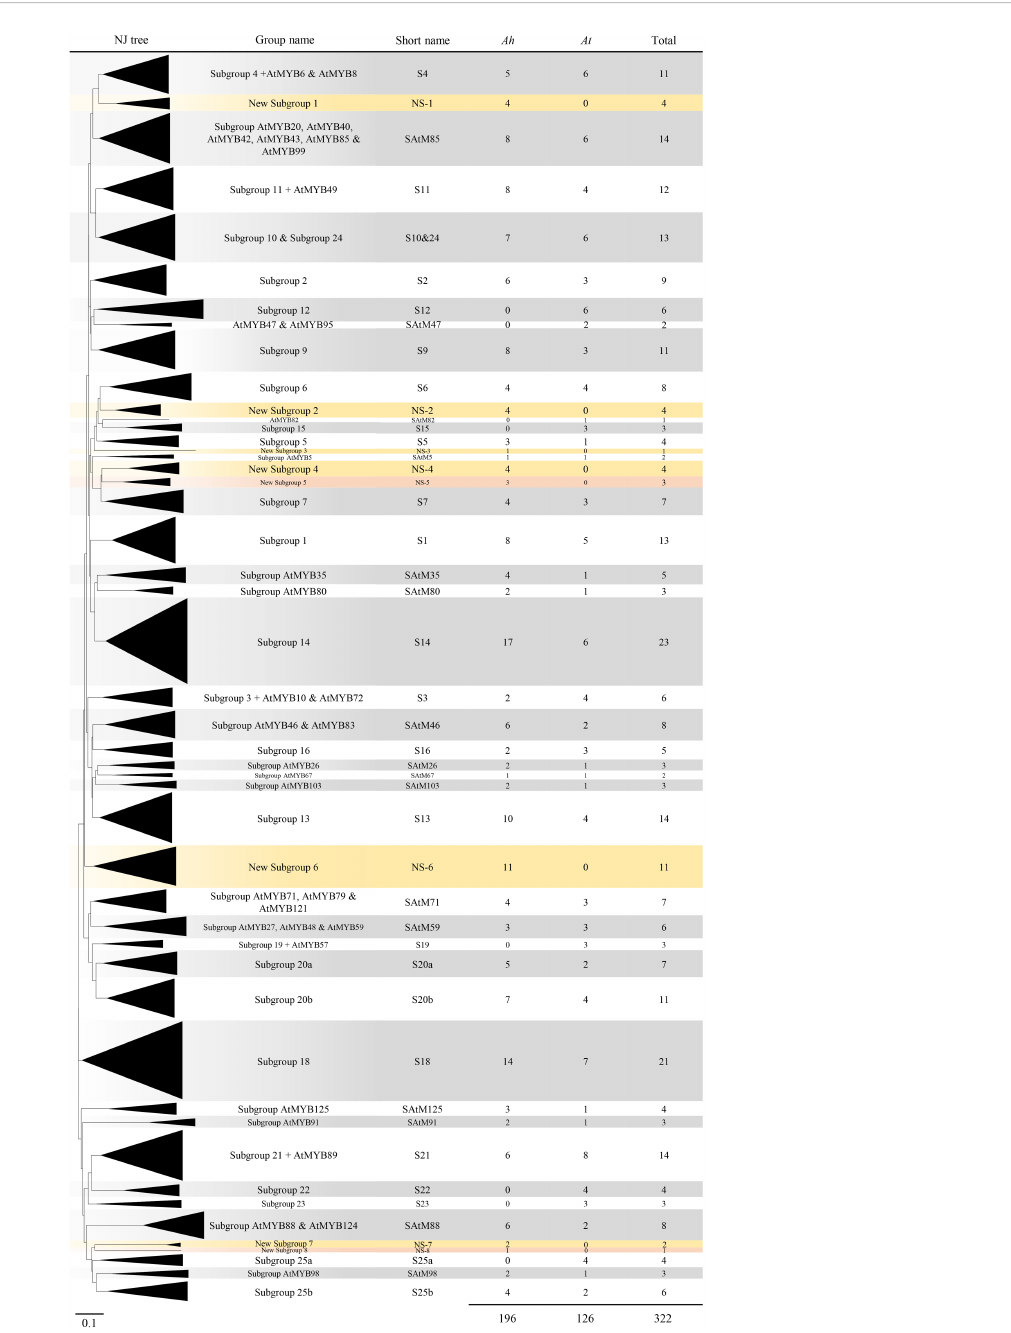
FIGURE 1 Neighbor-joining phylogenetic tree of R2R3-MYB proteins from peanut ( Arachis hypogaea L.) and Arabidopsis . Each triangle represented an R2R3-MYB subgroup, de fi ned based on the topology of the tree and the bootstrap values. Subgroup names were included next to each clade together with a short name to simplify the nomenclature. The number of genes of each species for each subgroup was also included. The eight new subgroups in peanut were marked in yellow or coral, while the other subgroups were in gray and